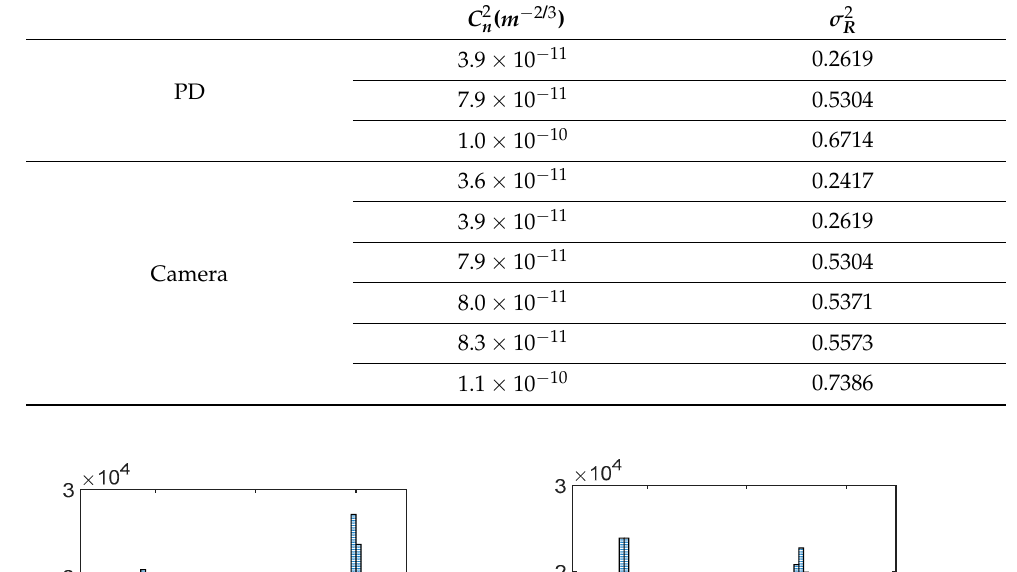
Figure 6. Waveforms of Rx data at varying AT strengths for the gain factors of: ( a ) 1.07 × and ( b ) 3.96 × [11].